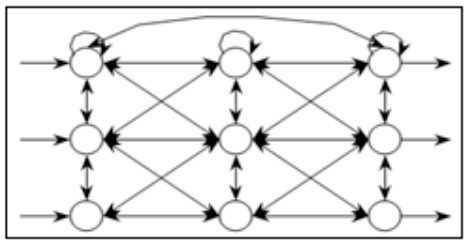
Figure 2. The general structure of a feedback network.